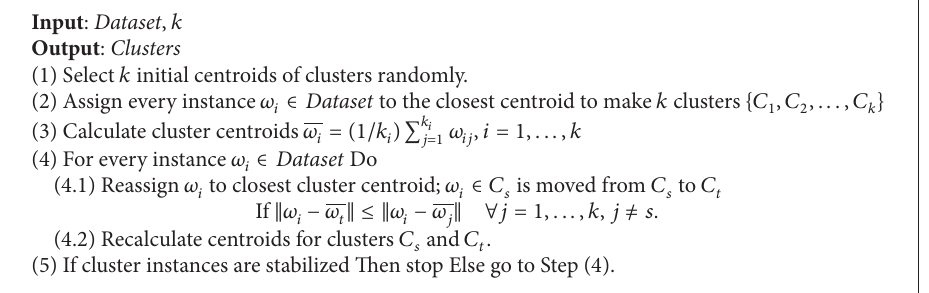
Pseudocode 1: Pseudocode of the standard 𝐾 -means